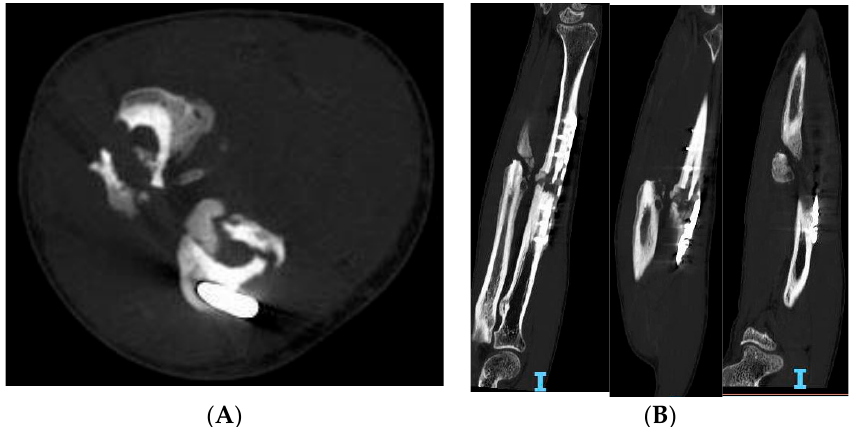
Figure 1. Forearm nonunion CT scans of a 43 ‐ year ‐ old patient. ( A ) Coronal view, ( B ) Sagittal